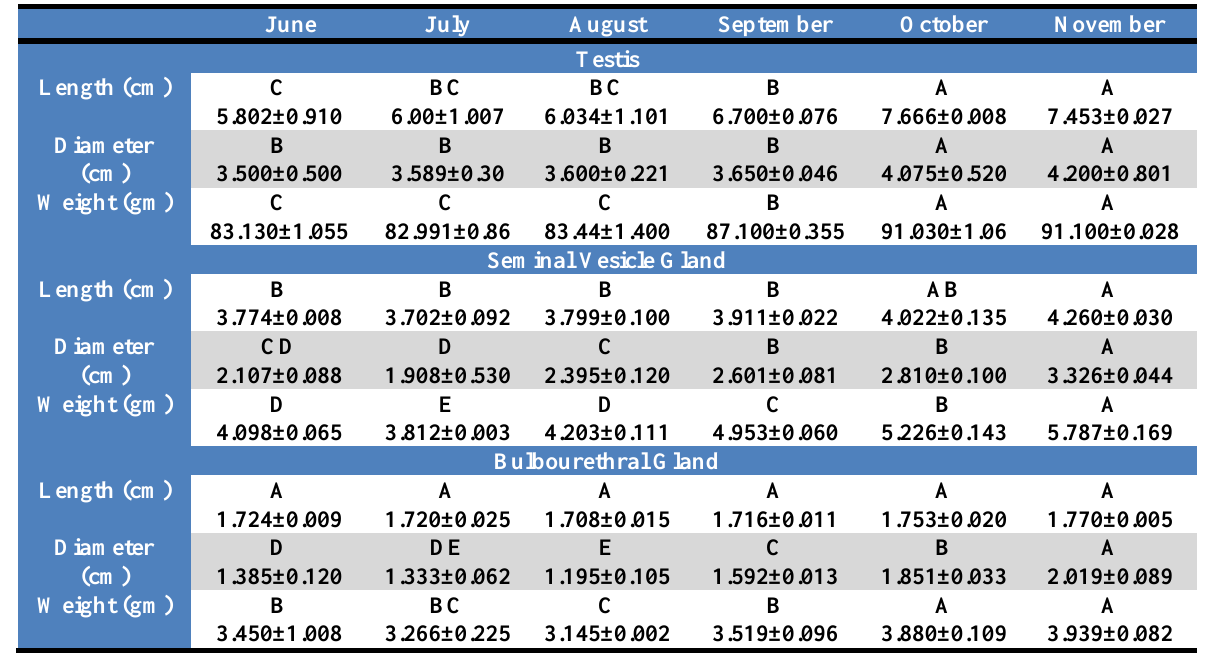
Table (1): Effect of heat stress on the testis, seminal vesicle and bulbourethral glands dimensions and weights during study months (M±SE)